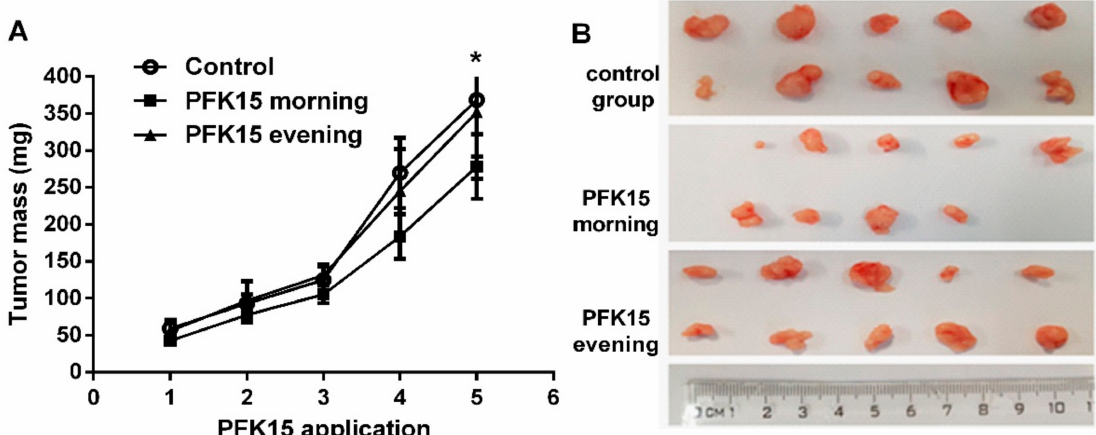
Figure 7. Changes in tumor size after PFK15 administration (control, morning, and evening groups). ( A ) Changes in the size of tumors were assessed after each PFK15 administration. The graph presents the changes in tumor mass in the control group compared to the groups that received morning or evening PFK15 treatment over 12 days (in total, 5 administrations). On day 14, tumor-bearing mice were sacrificed, and excised tumors were measured. Results are expressed as mean ± SEM for the control ( n = 5) and morning- and evening-treated groups ( n = 6) ( p < 0.05). ( B ) Photographs of tumors extirped from animals treated with the vehicle (control group) or PFK15 in the morning or evening. A ruler was used to measure (in mm) extirpated tumors after morning PFK15 treatment, evening PFK15 treatment, or vehicle administration.